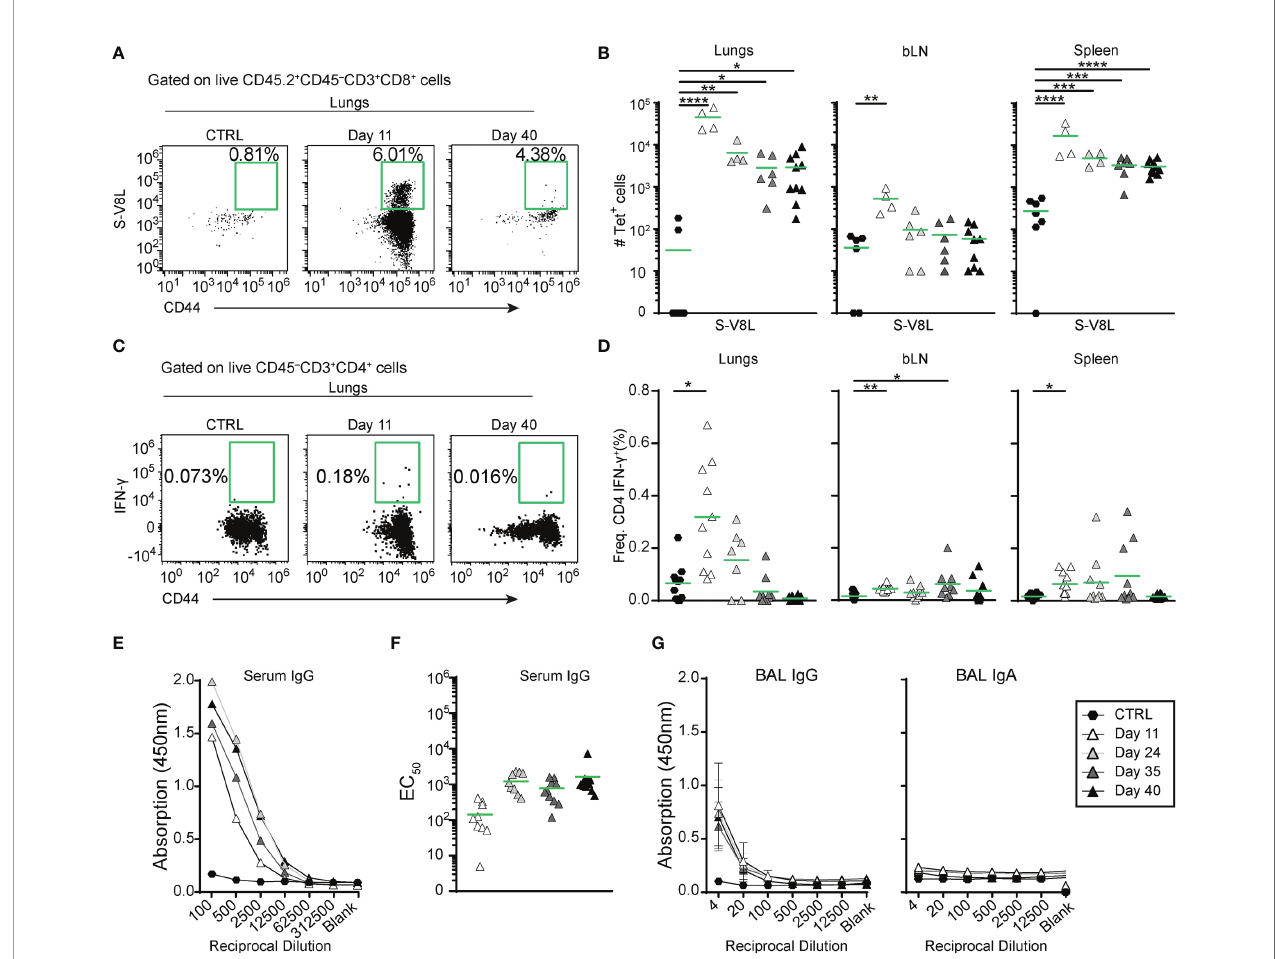
FIGURE 2 | A single intranasal vaccine application induces local and systemic spike-speci fi c cellular and humoral responses. (A, B) Spike-speci fi c CD8 + T cells accumulate in in the organs at different time points after vaccine application. (A) Representative dot plots and percentage of tetramer + lung CD8 + CD44 hi T cells in groups indicated. (B) Absolute cell counts of spike-speci fi c CD8 + CD44 hi T cells in different organs. (C, D) Spike-speci fi c CD4 + T cells transiently accumulate in lungs and spleens up to day 35 after immunization. (C) Representative dot plots and percentages of IFN- g -expressing lung CD8 + CD44 hi T cells of groups indicated after ex vivo re-stimulation with the pool of spike-speci fi c and immnodominant peptides ( Supplementary Table S2 ) for 6hr. (D) Frequencies of IFN- g -expressing CD4 + CD44 hi cells in different organs isolated from mice at indicated time points after i.n. vaccine administration. (E – G) Spike-speci fi c antibodies in serum (E, F) and broncho-alveolar lavage fl uid (BAL; (G) measured by ELISA. (E) Mean OD group values of serial serum dilutions and (F) and individual EC 50 values for Spike-speci fi c serum IgG for the groups indicated. (G) Mean group OD values in serial BAL dilutions for Spike-speci fi c IgG (left) and IgA (right). (B, D, F) Pooled data from 3-4 experiments with n = 4-10 mice per group. Individual values (symbols) and mean group value (line). Statistical analysis was done on log-transformed values using ordinary or Welch ’ s ANOVA followed by Dunnett ’ s T3 multiple comparisons test. *p < 0.05, **p < 0.01, ***p < 0.001, ****p <